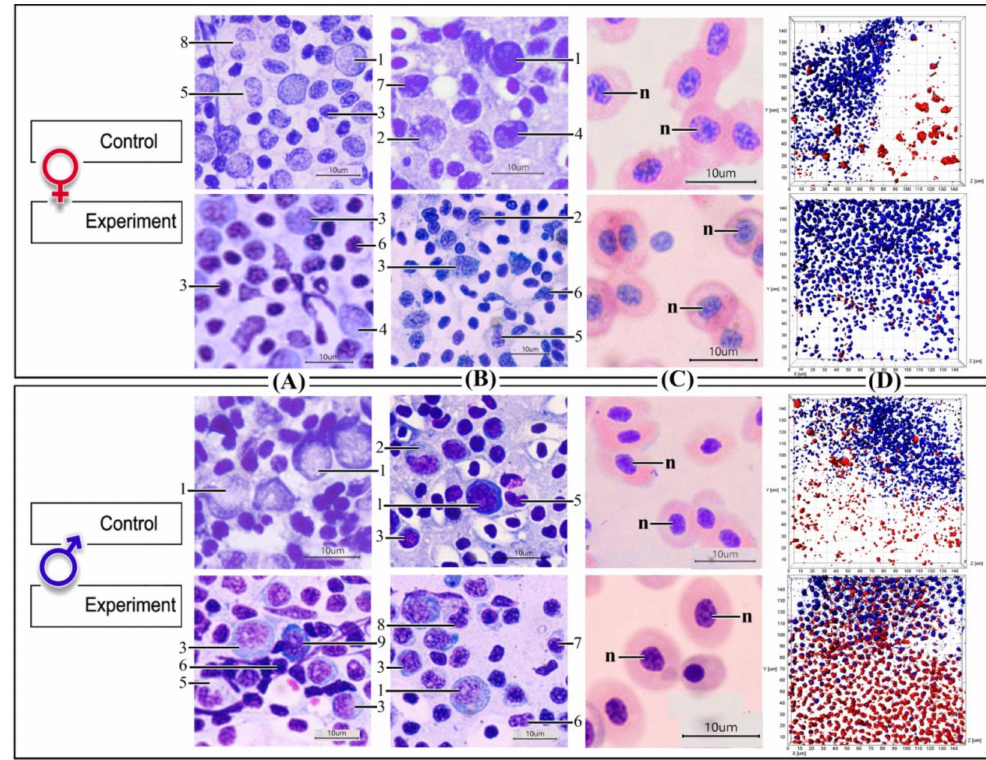
Figure 2. Blood parameters of stone sculpin males and females in control and seven days after the noise-exposure: ( A , B ) Cytometric parameters of blood cells in the hematopoietic organs ( A — kidneys and B —spleen) of stone sculpin: 1—lymphoblasts, 2—myeloblasts, 3—prolymphocytes, 4— promyelocytes, 5—promonocytes, 6—lymphocytes, 7—myelocytes, 8—neutrophils, 9—plasmocytes (light microscopy); ( C ) Red blood cells in peripheral blood (light microscopy), n—red blood cell nucleus; ( D ) The volume of the fluorescent signal from native mitochondria (in red) of the red blood cells with a conserved membrane potential (functionally active mitochondria): staining for mitochondria (MitoTracker Orange CMTMRos, red) and for nuclei (DAPI,